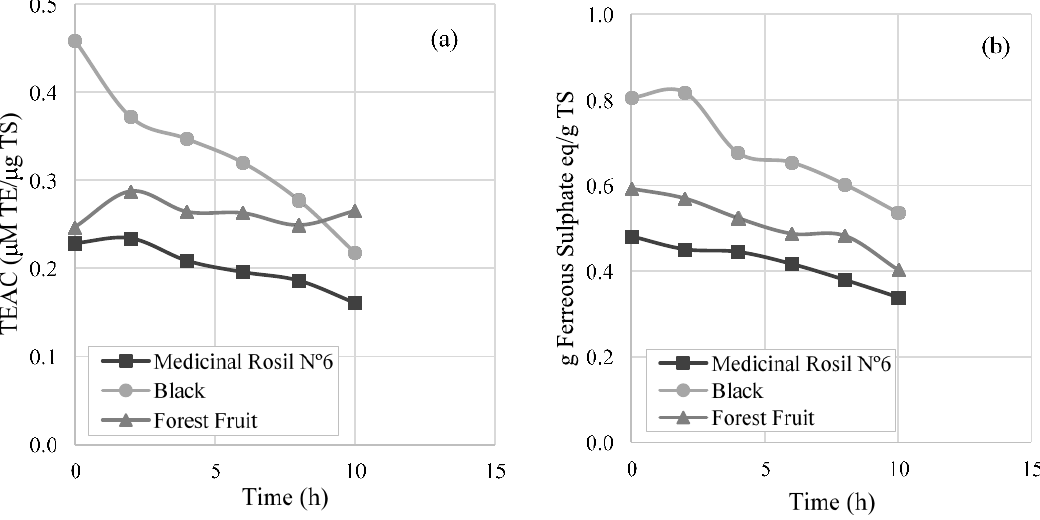
Figure 7. Antioxidant activity through concentration process by ( a ) DPPH (2,2-diphenyl-1-picryl- hidrazil) method and ( b ) Ferric reducing ability power (FRAP) method. TEAC: Trolox equivalent antioxidant activity; TS: total soluble solids.